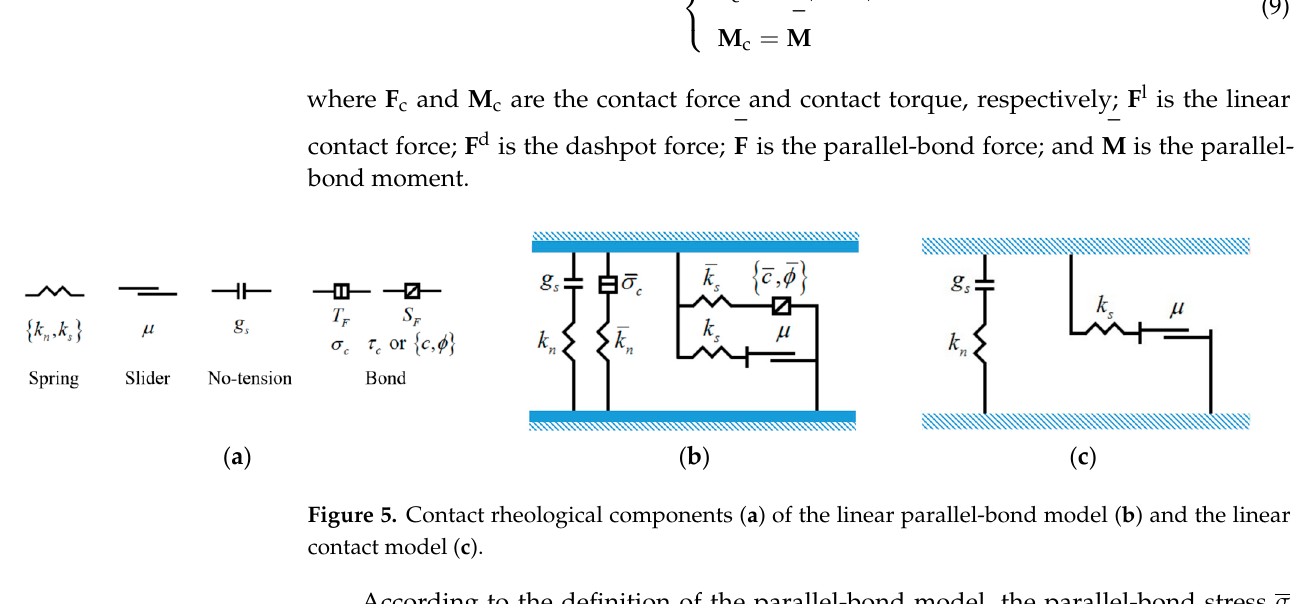
Figure 4. Sketch of the bound contact model.